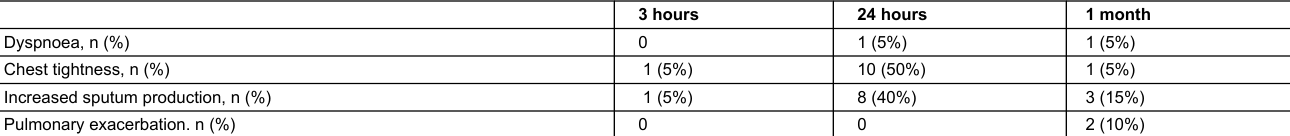
Table 1: Respiratory-related adverse events from patients (n = 20), at 3 hours, 24 hours and 1 month, according to Popowicz et al [10].